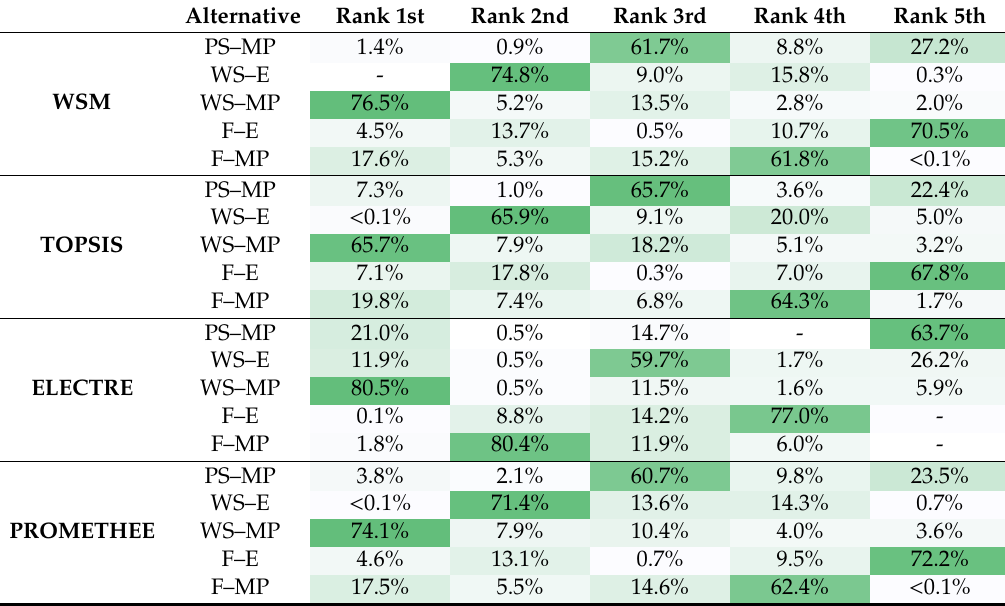
Table 8. Rank probabilities with stochastic weights considering the dimension-indicators hierarchy.